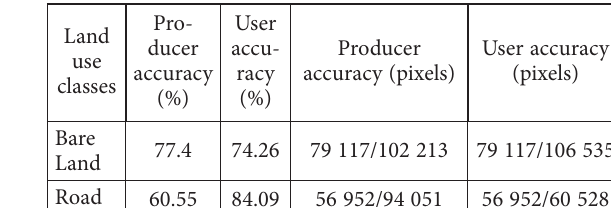
Figure 6. Object based classification map